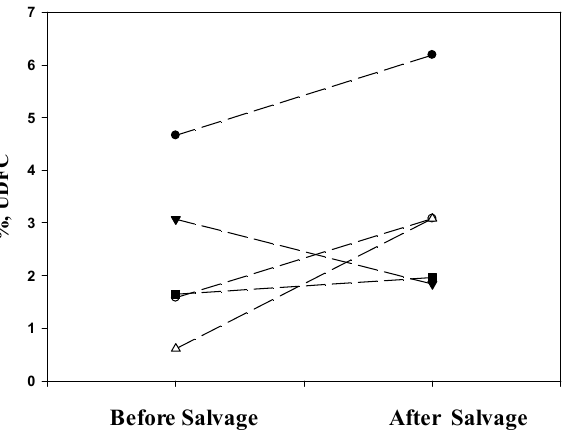
Figure 7. Percentage of undeformable cells (%UDFC) in RBC population before and after salvage.